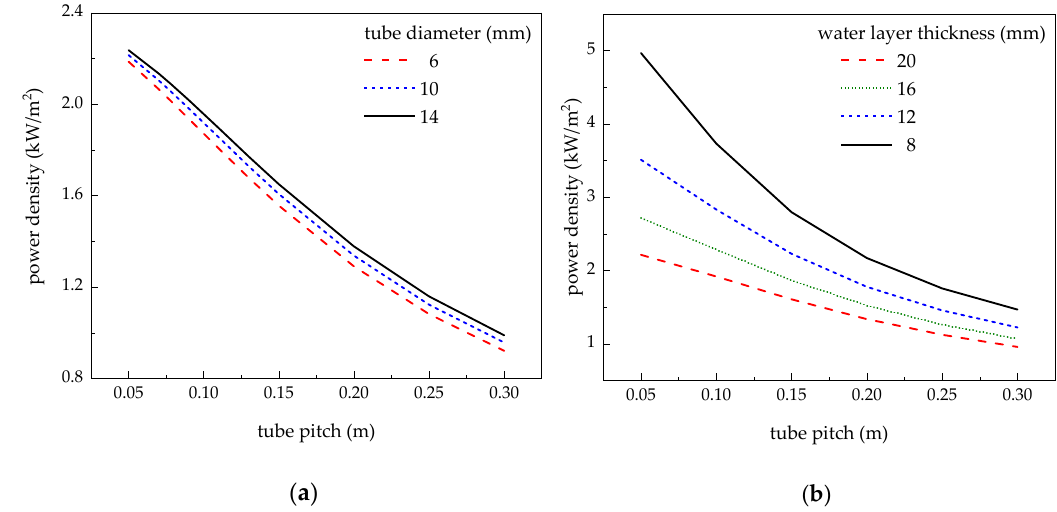
Figure 7. Effect of tube pitch on heat exchange power density. ( a ) water layer thickness = 20 mm. ( b ) tube diameter = 10 mm.